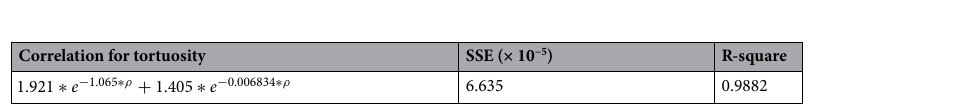
Table 8. Empirical tortuosity–average pore size correlation for porous media. Sum of squared error of prediction (SSE) and R-squared for the possible correlation. Where ρ is the average pore size.